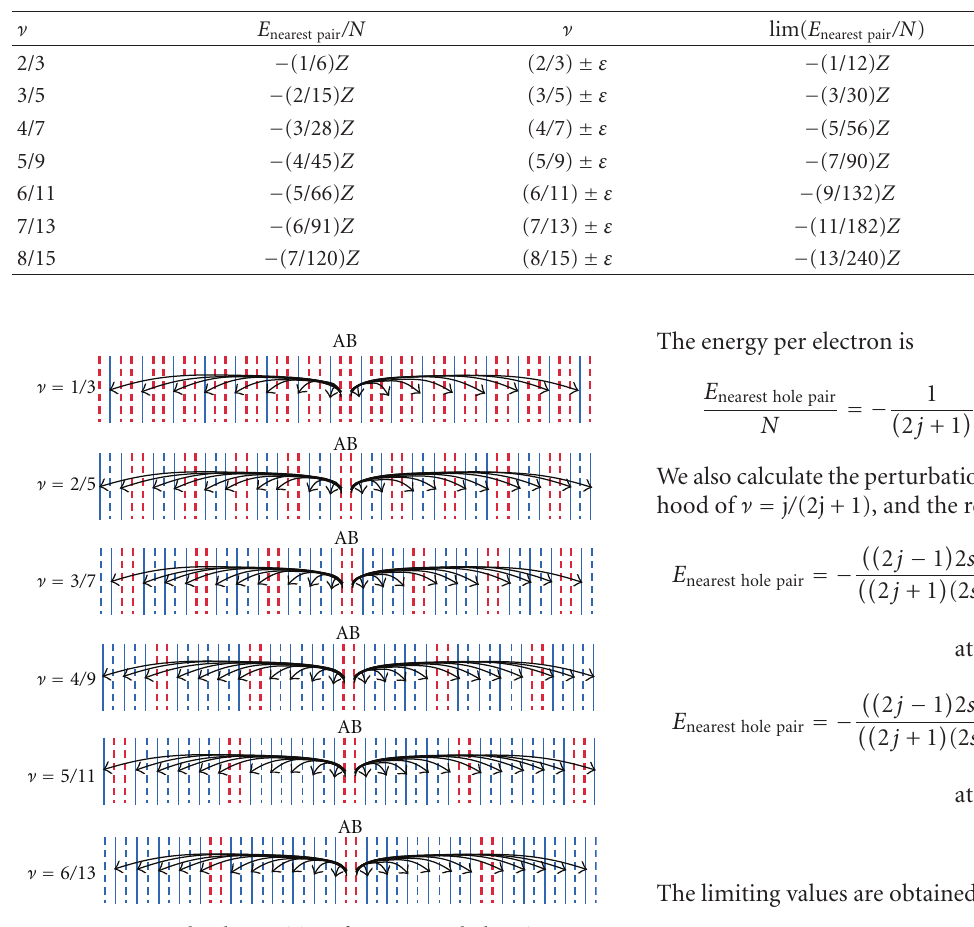
Figure 11: Coulomb transitions from nearest hole pair AB.